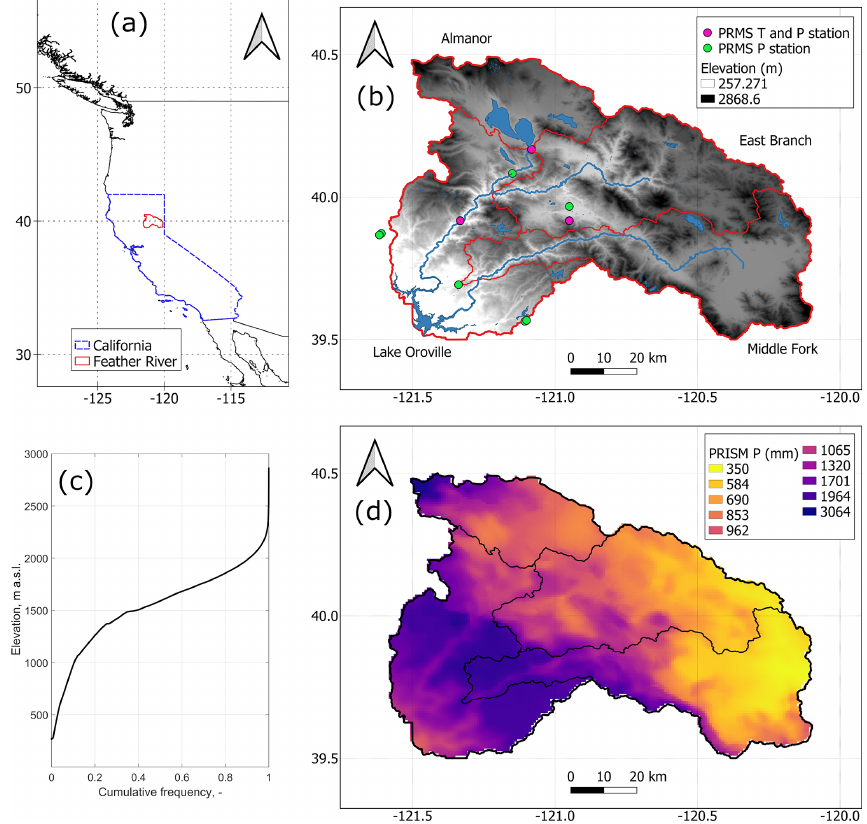
Figure 1. The Feather River at Oroville and its three headwater sub-basins under study (Almanor, East Branch, and Middle Fork): location of the river along the Pacific coast of North America (a) , orography and hydrography, along with in situ temperature and precipitation stations used to force PRMS (see Sect. 2.3.2) (b) , cumulative-frequency distribution of the river basin’s elevation (c) , and PRISM 1981–2010 average annual precipitation (d)